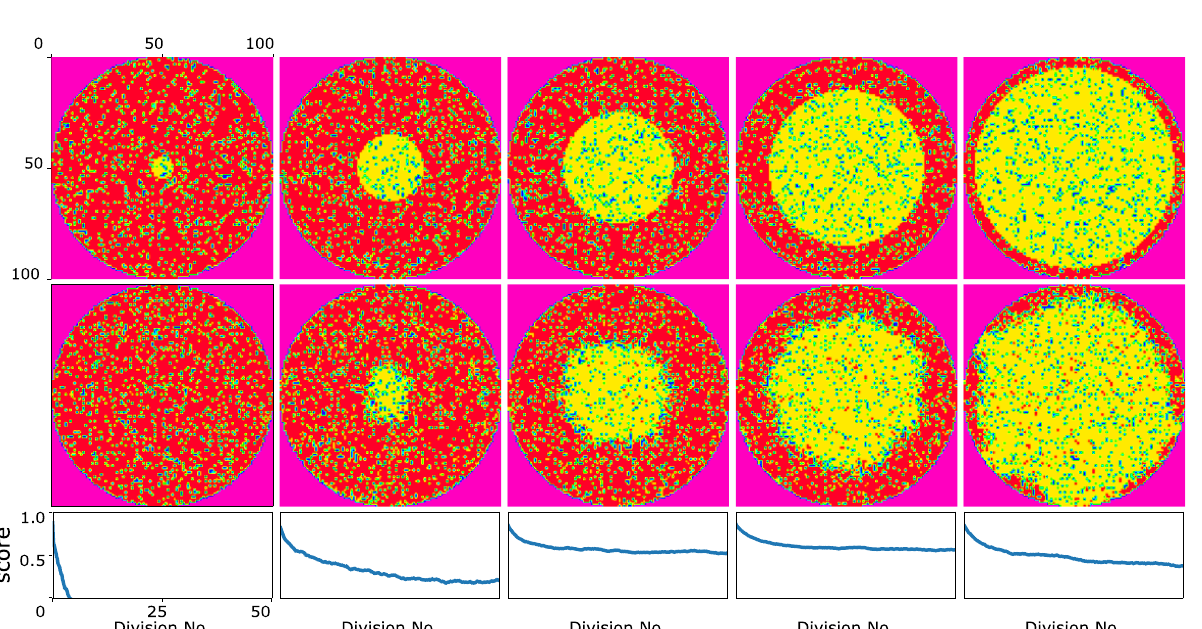
Figure 4. The system behaviour for different simulations. The first, and second rows represent the initial, an final states of the system, respectively. The corresponding score diagram of five mentioned simulations are shown in the last row. ( a ) Five different simulations with the dish radius of 50, but different inner disk size, 5, 15, 25, 35, and 45 from left to right. ( b ) Five different simulations with the dish radius of 50, but different inner disk size, 5, 15, 25, 35, and 45 from left to